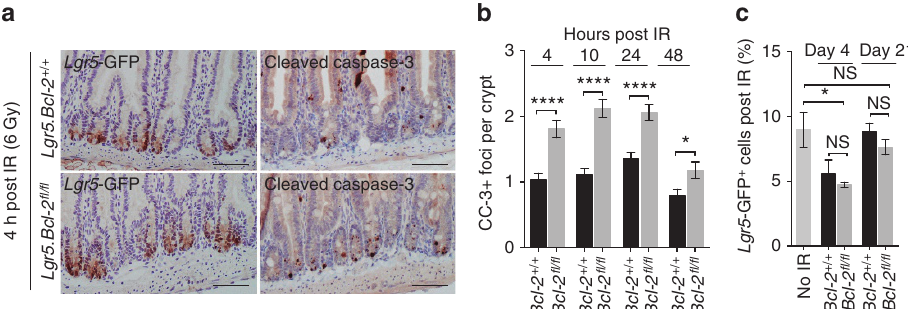
Figure 3 | Bcl-2 is dispensable for ISCs during regeneration. ( a ) Panel of sections stained for cleaved caspase-3 (CC-3) in Lgr5.Bcl-2 þ / þ mice (top) and Lgr5.Bcl-2 fl/fl mice (bottom) 5 weeks after tamoxifen induction and 4h after 6Gy full-body irradiation. Scale bars, 100 m m. ( b ) Graph displaying the percentage of CC-3 foci per crypt for Lgr5 . Bcl-2 þ / þ and Lgr5 . Bcl-2 fl/fl mice at the indicated time points post 6Gy irradiation. A minimum of 80 crypts was counted for each genotype and time point. Error bars represent the s.e.m., * P o 0.05, **** P o 0.0001, Student’s t -test. ( c ) Graph showing the percentage of Lgr5 -GFP þ cells in the small intestine for non-irradiated controls and post-irradiated mice at the indicated days ( n ¼ 3 mice per condition, per time point). Analyses are performed by FACS. Error bars represent the s.e.m., NS, not significant, * P o 0.05, Student’s t -test.